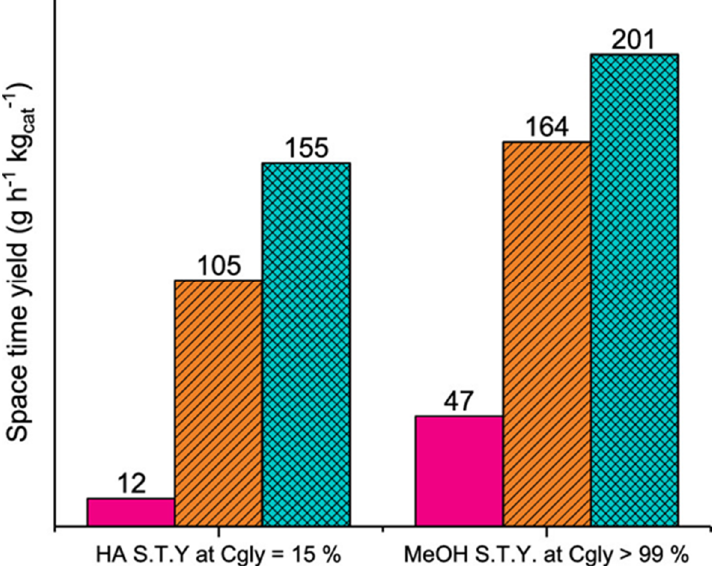
Figure 3. “Hydroxyacetone and methanol STYs over Ce-C (pink), Ce-R (orange lined), and Ce-P (blue hatched), where catalyst mass and carrier flow rates were altered to achieve glycerol conversions of ca. 15% and >99%. Low conversion reactions performed at 320 °C; high conversion reactions performed at 400 °C and GHSVs between 1800 and 11,250 h −1 .” Figure and caption reproduced from ref. [59] with permission from the American Chemical Society.